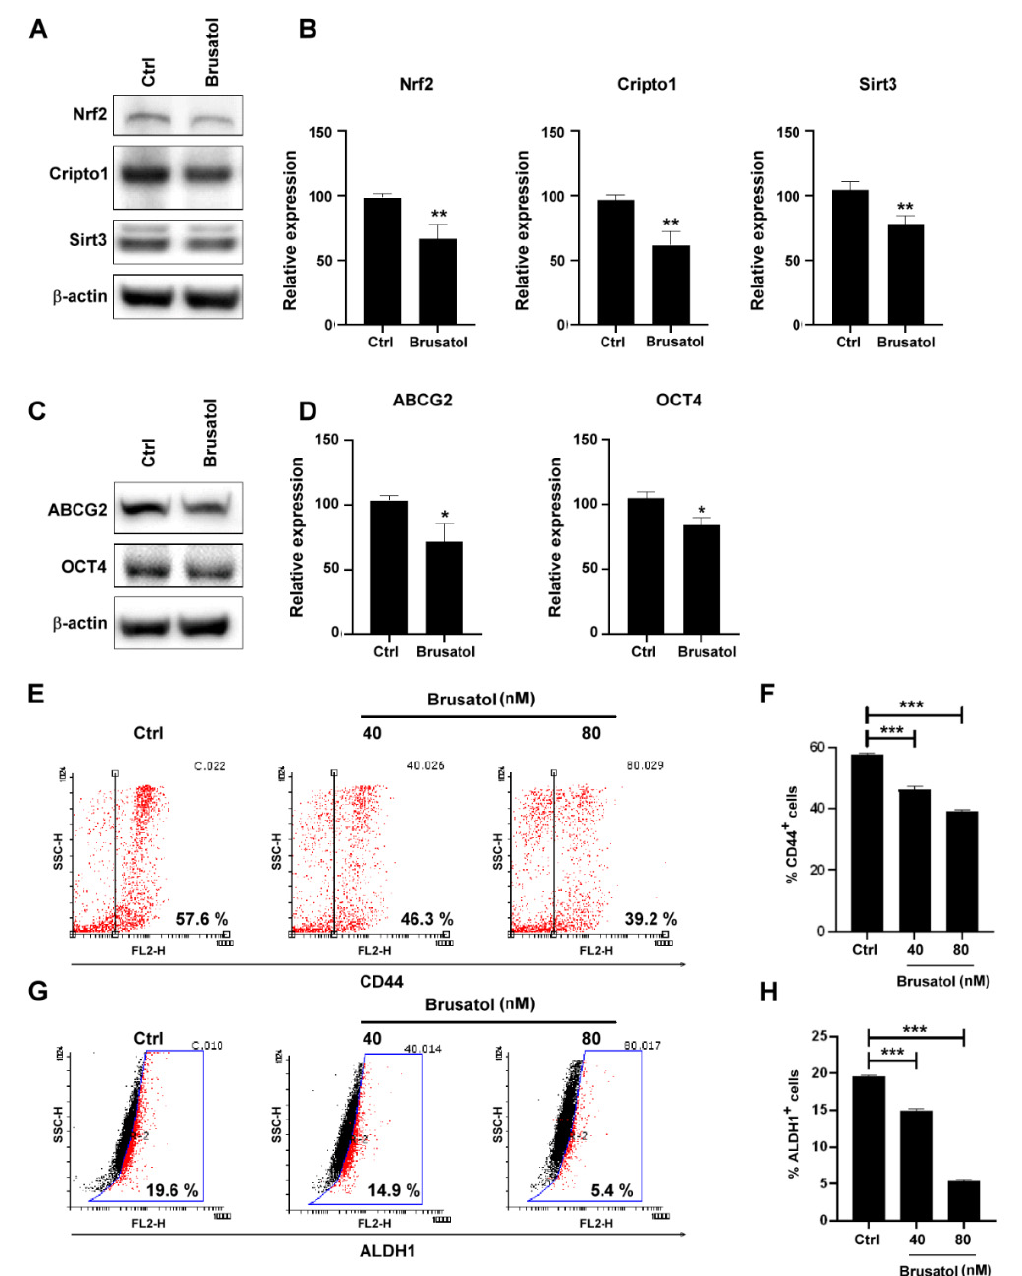
Figure 3. Brusatol regulated the expression of Cripto1, Sirt3, CD44, and ALDH1: ( A ) Nrf2, Cripto1, and SIRT3 expression was analyzed via Western blot after 48 h of brusatol treatment; ( B ) quantification of Nrf2, Cripto1, and Sirt3 expressions; ( C ) ABCG2 and OCT4 expressions were analyzed through Western blot after 48 h of brusatol treatment; ( D ) quantification of ABCG2 and OCT4 expression; ( E ) CD44 expression was analyzed through flow cytometry after 48 h of brusatol treatment; ( F ) quantification of CD44 expression; ( G ) ALDH1 + cells were analyzed through flow cytometry after 48 h of brusatol treatment; ( H ) quantification of ALDH1 + cells. Data are shown as the means ± standard errors of the mean of at least three independent experiments. Student’s t -test: * p < 0.05, ** p < 0.01, *** p < 0.001.